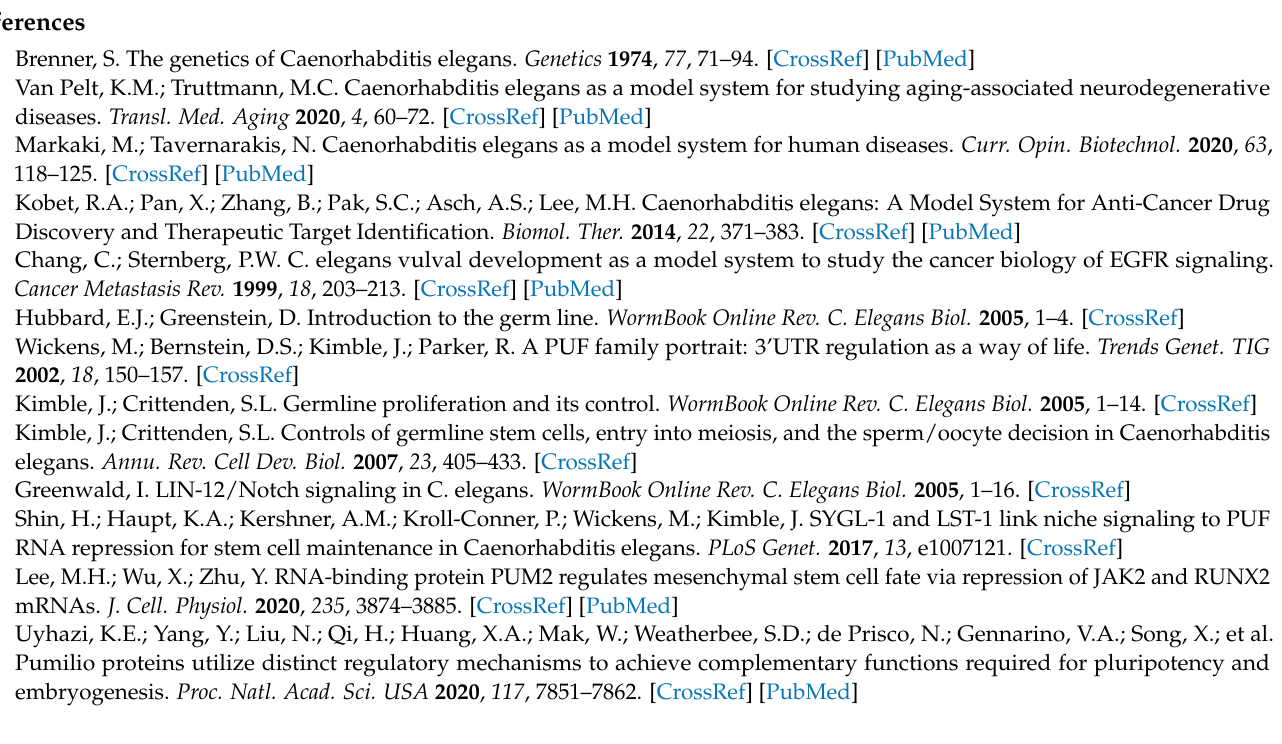
Table S2: Antibodies used in this study; Figure S1: The effect of bacteria foods on